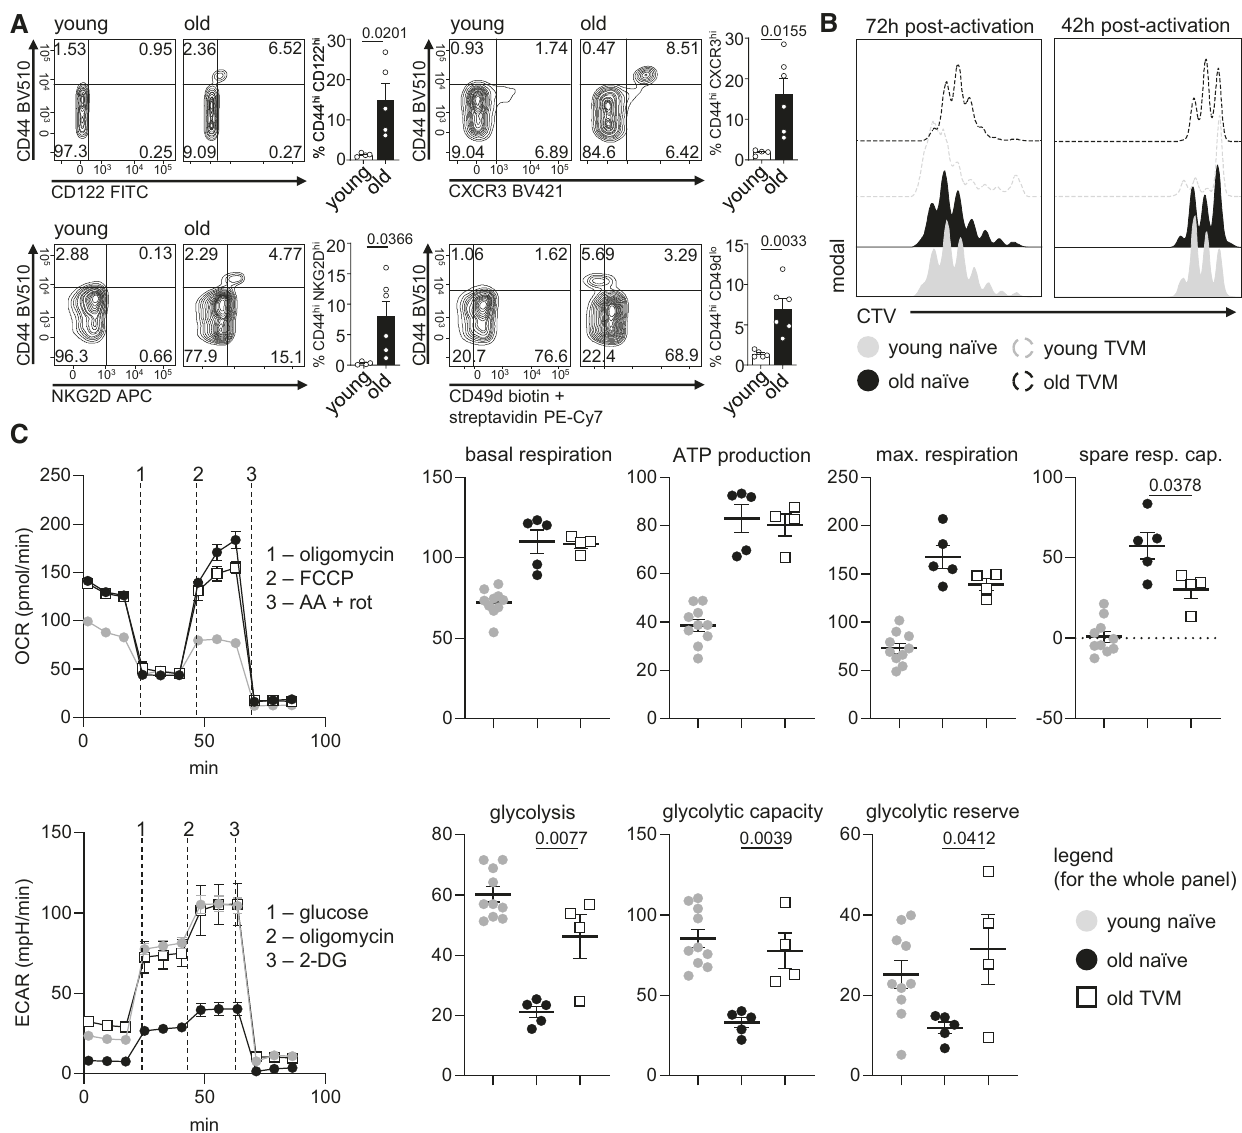
Fig. 3 T VM cells have a unique proliferative and metabolic phenotype. A Representative fl ow cytometry plots showing CD122, CXCR3, NKG2D and CD49d expression on CD8 + T cells in the blood of young and old P14 mice. Frequencies of CD44 lo and CD44 hi CD8 + T cells expressing high CD122, CXCR3 and NKG2D levels and low CD49d levels are depicted in the bar graphs. Pooled data from two independent experiments (young, n = 4: old, n = 5; aged mice: 70, 90 or 100 weeks old). B Histograms depicting proliferation of puri fi ed naive or T VM CD8 + T cells from young or aged mice (CTV-labelled, stimulated on α -CD3, α -CD28 and human Fc-ICAM-1 coated wells). After 42 h, the proliferation pro fi le was analyzed by CTV dilution (left panel) or cells were transferred to uncoated wells for further 30 h in medium containing IL-2, IL-7 and IL-15, until their proliferation kinetics was assessed 72 h post stimulation (right panel). Representative data from one out of two experiments (aged mice: 70 or 82 weeks old). C Oxygen consumption rate (OCR) (upper panel) and extracellular acidi fi cation rate (ECAR) (lower panel) of activated CD8 + T cells was measured under basal conditions and in response to indicated drugs. Representative data from one out of two experiments, where data points are technical replicates (young naive, n = 10; old naive, n = 5, old TVM, n = 4; aged mice > 100 weeks old in all experiments). Data are depicted as mean ± SEM. Statistical analysis was performed using the unpaired two- tailed Student ’ s t test. Exac t P values are depicted in the fi